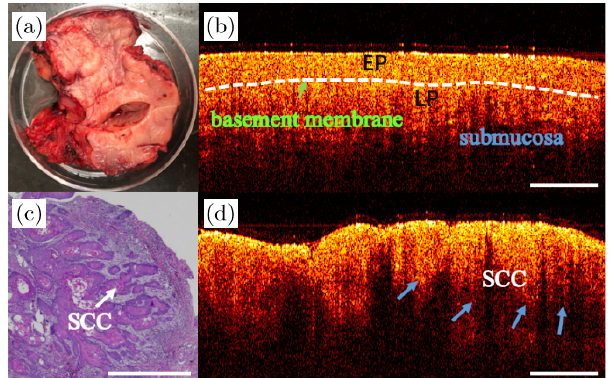
Fig. 3. OCT and the corresponding histology of SCC. (a) Photo of the excised tissue specimen. (b) and (d) The 2D OCT images of two di®erent positions from the same specimen. Panel (b) shows normal oral mucosa, and panel (d) shows the SCC. (c) The corresponding histopathological image of SCC. SCC: squamous cell carcinoma, EP: epithelial layer and LP: lamina